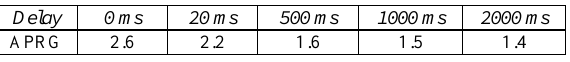
Table 1. Average Perceptual Resolution Gain achieved with corresponding